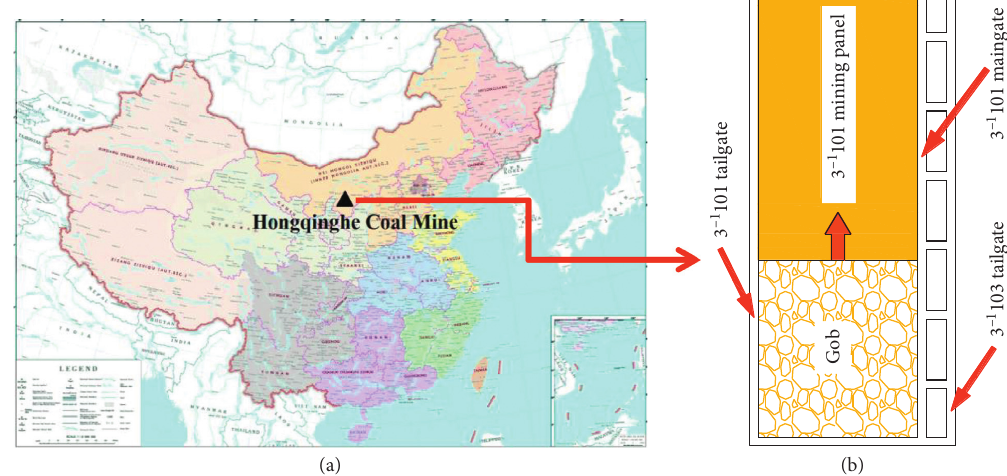
Figure 1: Coal mine location and roadway layout: (a) location of the coal mine; (b) layout of mining panel.